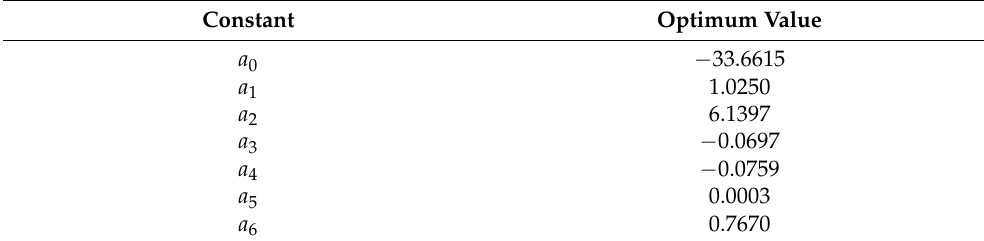
Table 4. Optimum fitting constants for the permeate flux.